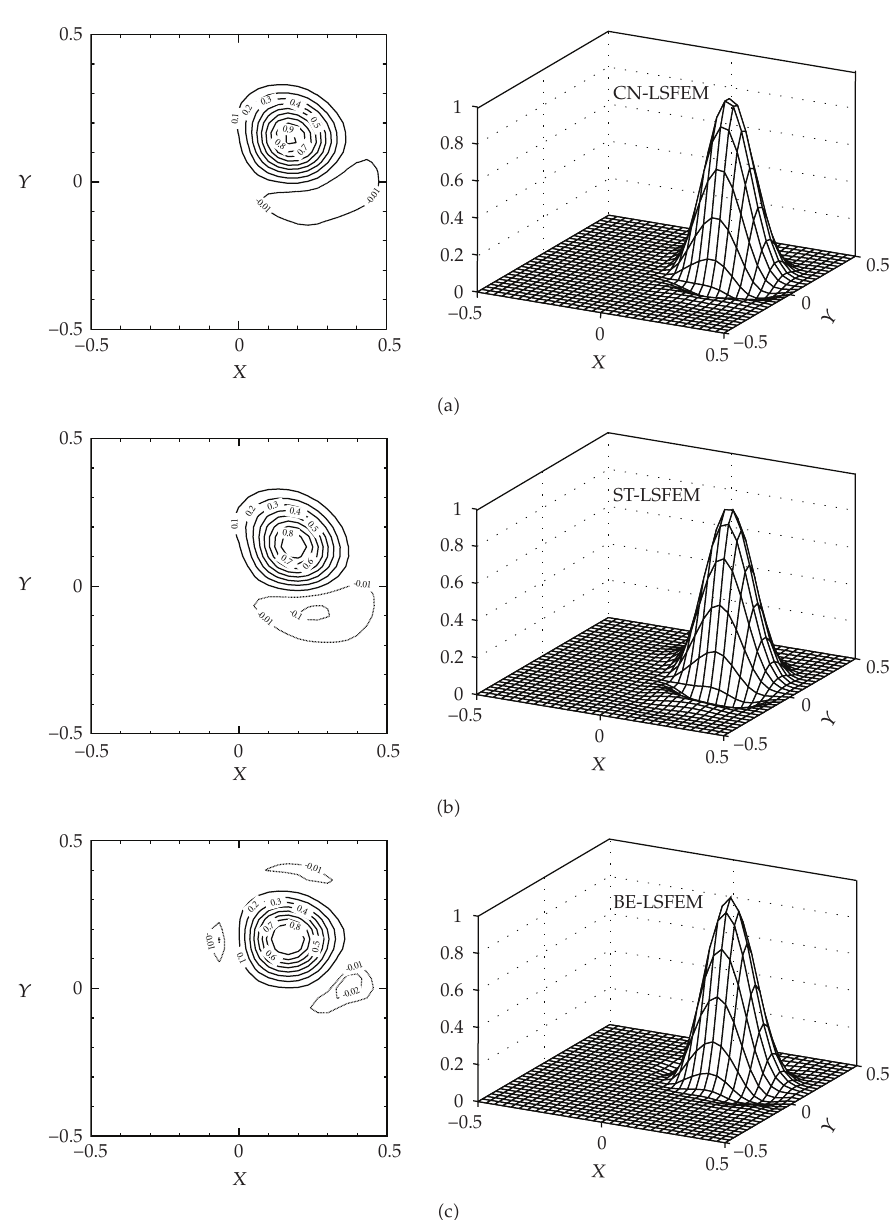
Figure 7: Convection of a cosine hill in a pure rotational velocity field with (cid:2) t (cid:9) 2 π/ 60 : comparison of results after a complete